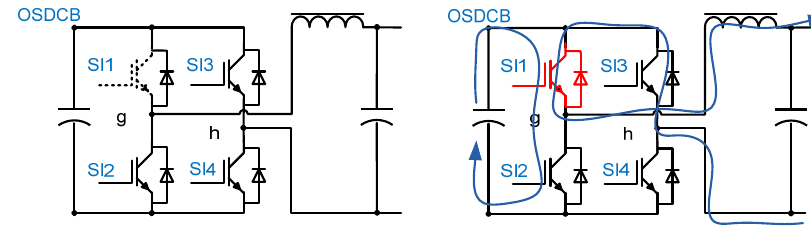
Figure 11. Schematic diagrams of output stage for ( a ) Fault G1 (IGBT SI1